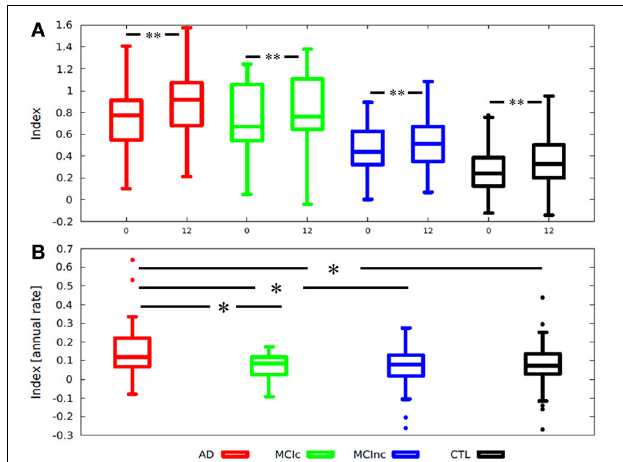
FIGURE 2 | Box-plots illustrating the distribution of (A) an MRI index according to diagnosis and stratified by time point; (B) Index annual rate of change stratified by diagnosis. Index annual rate of change = index at 1-year − index at baseline. ∗ One-tailed T -test p < 0 . 002; ∗∗ One-tailed paired T -test p < 0 . 003; AD, Alzheimer disease; MCI-c, MCI converter; MCI-nc, MCI non-converter (stable); MCI, mild cognitive impairment; CTL, healthy control.